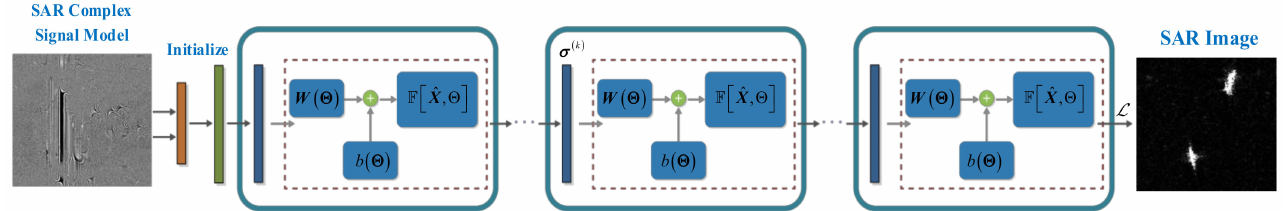
Figure 2. Overall framework of the proposed SAR deep learning imaging method.